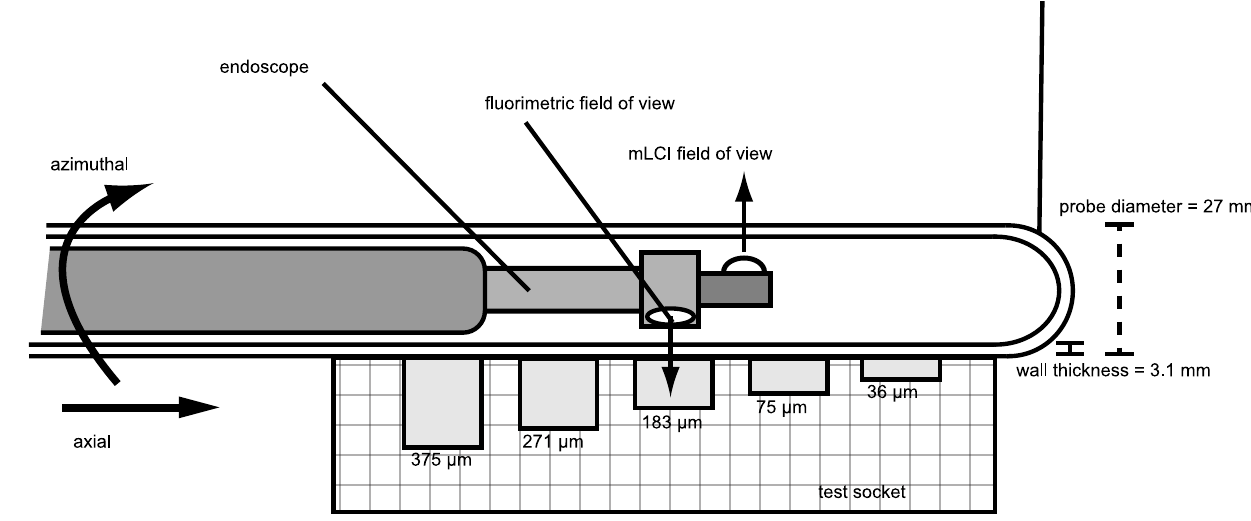
Figure 1. Imaging probe geometry as used with the test socket. The internal endoscope, which includes both the mLCI and fluorimetry imaging systems, rotates together freely inside the epoxy tube. The mLCI field of view is offset + 20-mm in the axial direction and 180-degrees azimuthally. The test socket consists of grooves at five depths, ranging from 36–375 m m.